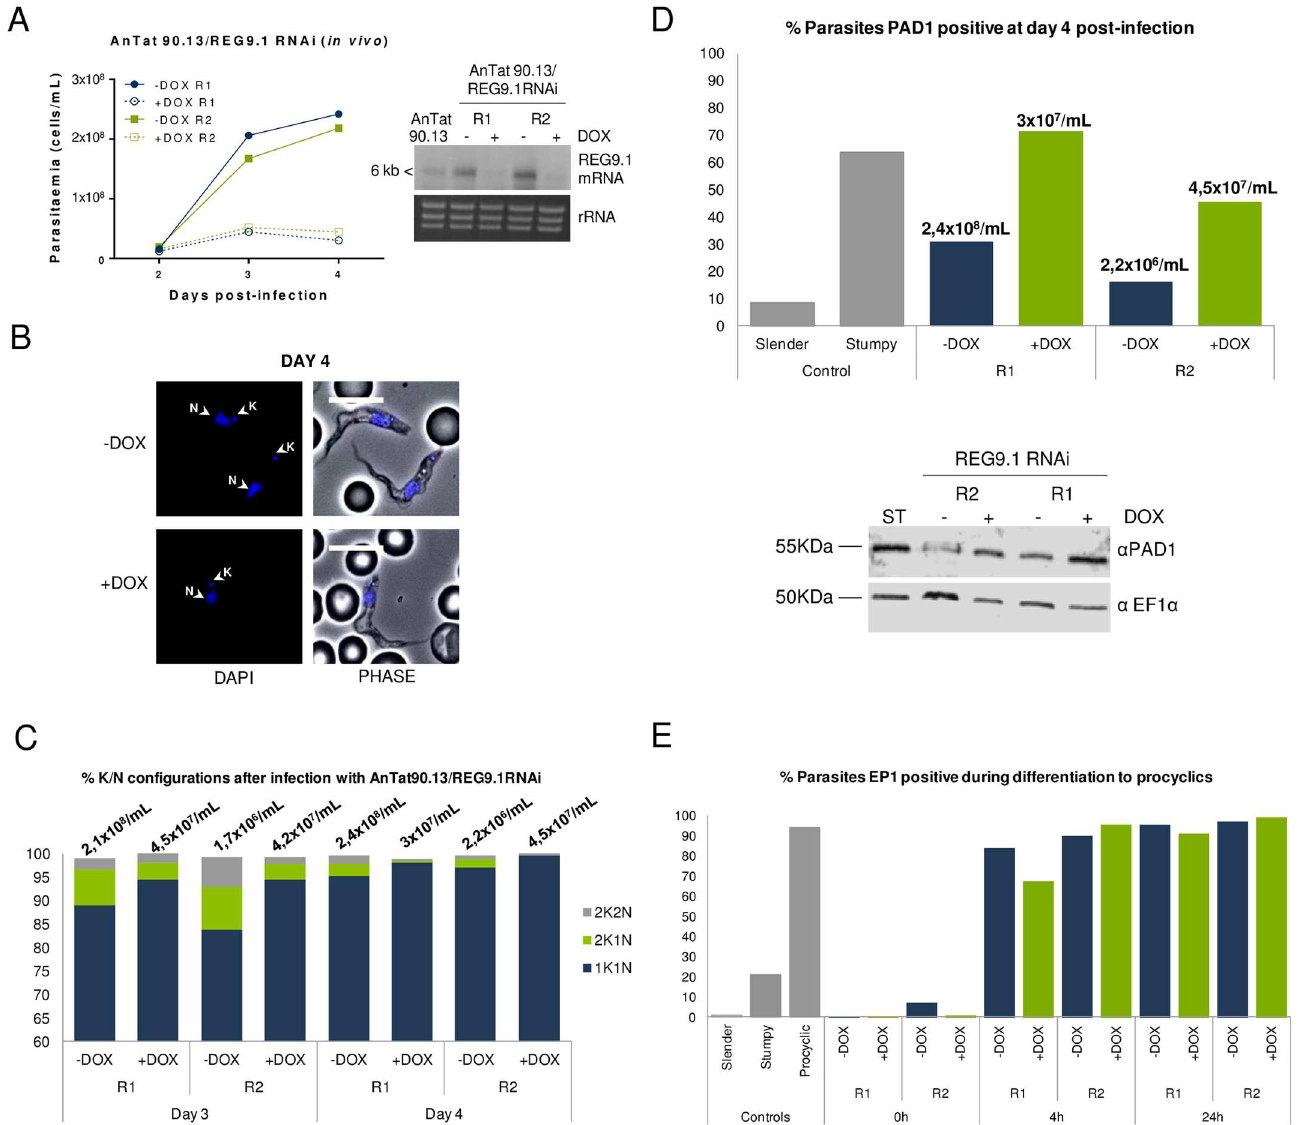
Fig 4. Phenotype of REG9 . 1 gene silencing in vivo . A. Growth of REG9 . 1 pleomorphicRNAi lines in vivo , with RNAi inducedor not by doxycycline. The inset shows the respectiveabundance of REG9 . 1 transcript in each case after cells were harvestedon day 4 post infection and RNA prepared. Two mice replicates (R1 and R2) were used for each condition(–DOX and +DOX). B. Morphology of cells on day 4 of infection. Two cells are shownfor the uninducedpopulation, both being ‘intermediate’ in morphology, althoughthe upper cell is somewhat more stumpy with the nucleusmore proximal to the kinetoplast; in the inducedpopulationa stumpy cell is shown, with the nucleusmoved toward the cell posterior. Hence although at a much lower parasitaemia (see panel A), the stumpy morphology of inducedcells was equivalent to, or greater than, uninduced cells. The DAPI panel at the left hand side shows the positionsof the nucleus(N) and kinetoplast (K) in each case Bar = 10 μ m.C. Cell cycle profile of pleomorphic RNAi lines (R1, R2) inducedor not to silence REG9 . 1 expression. The kinetoplast/nuclear configurationwas assessedon day 3 and day 4 of infection, with the associated parasitaemia shown above each bar. At least 250 cells were countedfor each condition/replicate/day. D. PAD1 expression profile determined by flow cytometry in the REG9 . 1 RNAi lines (R1, R2) inducedor not, with slender or stumpy T . brucei AnTat1.1 cells as controls. The parasitaemia of each populationat harvest is shown. PAD positivity was determined by gating with respect to the Slender(negative)and Stumpy (positive)control samples. Below the chart is the PAD1 expressionprofile determinedby western blotting in the REG9 . 1 RNAi lines (R1, R2) inducedor not, when harvested, with stumpy AnTat1.1 cells as control (‘ST’). EF1 α abundance was used as a loadingcontrol. E. Flow cytometry of the expressionof EP procyclinduring differentiationto procyclicforms of each REG9 . 1 RNAi line (R1, R2) 0h, 4h and 24h after exposureto 6mM cis aconitate. EP procyclinexpressionon slender, stumpy and procyclic forms provide controls. A low level of EP procyclinexpressionis detected on stumpy cells, this being inducedduring isolationand cell preparation procedures. Althoughat lower parasitaemia (panelA) the inducedcells differentiateas effectively as uninducedcells demonstrating the physiological relevanceof the stumpy forms